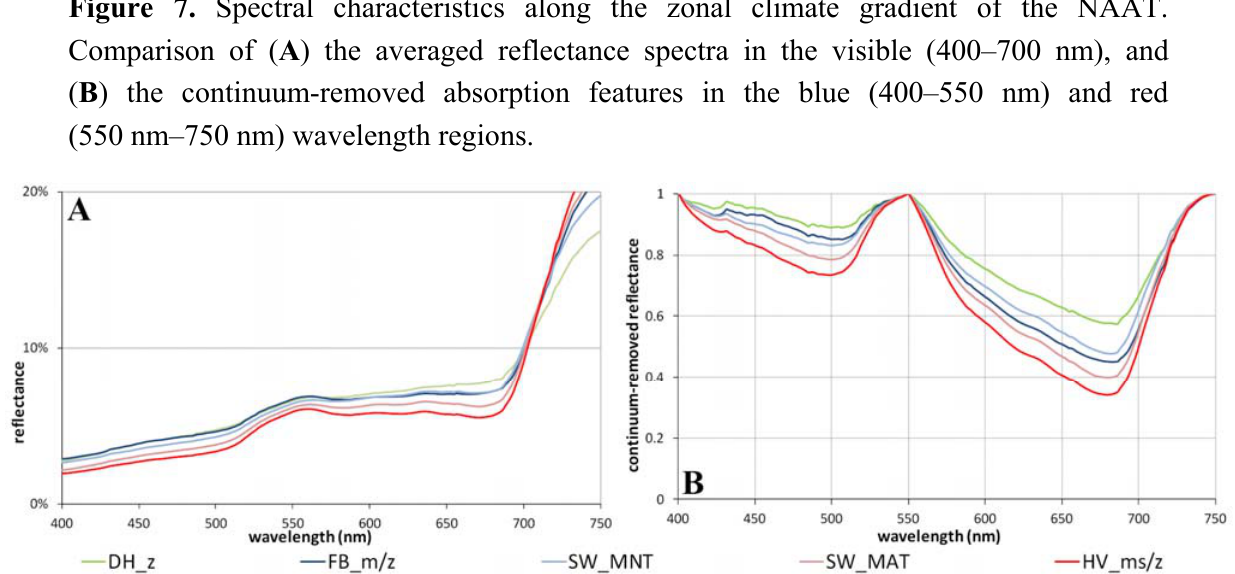
Figure 7. Spectral characteristics along the zonal climate gradient of the